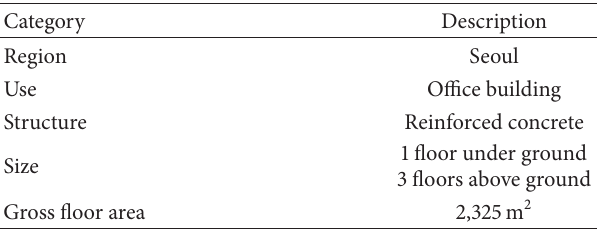
Table 5: Overview of the target